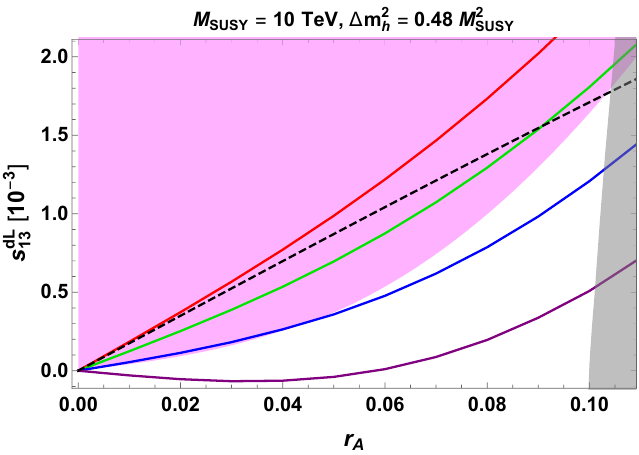
Figure 3 . The parameter space allowed by the EWSB and SUSY FCNC constraints in ( r A ; s dL plane. The color plots show the same meanings as in (cid:12)gure 2. In this (cid:12)gure, the red, green, blue, and purple lines correspond to r h = 1 : 42, 1 : 44, 1 : 46, and 1 : 48,